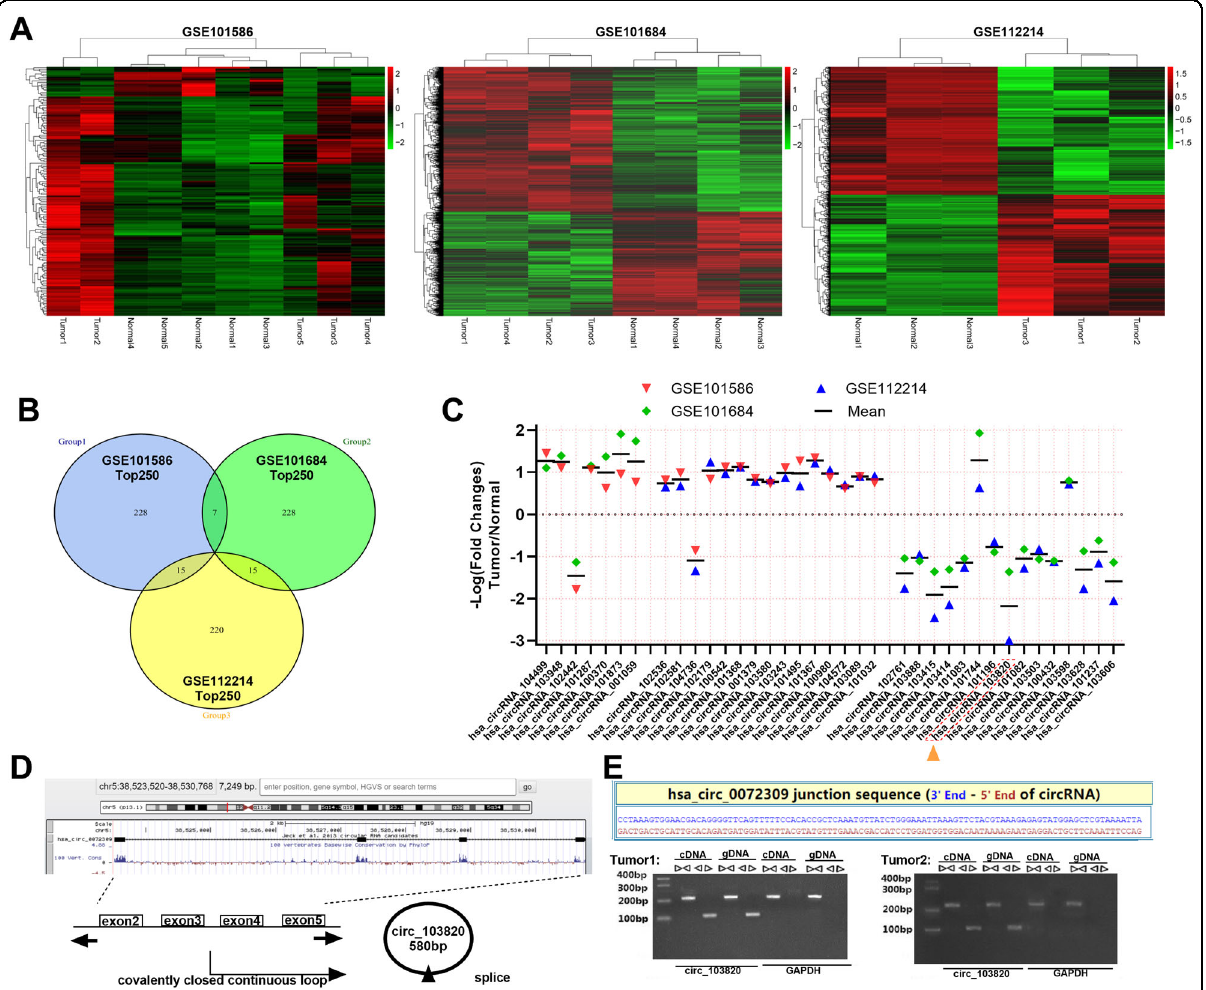
Fig. 1 Screening and identi fi cation of hsa_circ_103820 in lung cancer. A GEO2R was adopted to obtain the top 250 differentially expressed circRNAs in GSE101586, GSE101684, and GSE112214, and hierarchical clustering was utilized to display the expression pro fi le of the obtained circRNAs between paracarcinoma tissues and lung cancer tissues. B The top 250 circRNAs from GSE101586, GSE101684, and GSE112214 were analyzed using a Venn diagram. C The expression changes of the overlapping circRNAs are presented based on the log (fold changes) values. D A diagram of hsa_circ_103820 location and splicing pattern is presented. E cDNA and gDNA were ampli fi ed by using convergent primers and divergent primers in two lung cancer tissues. gDNA, genomic